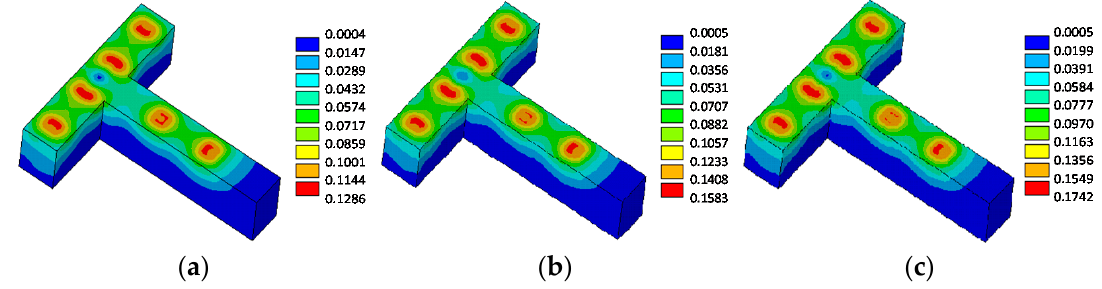
Figure 6. Distribution of magnetic flux density: ( a ) 100 A, ( b ), 150 A, ( c ) 200 A (unit: T).